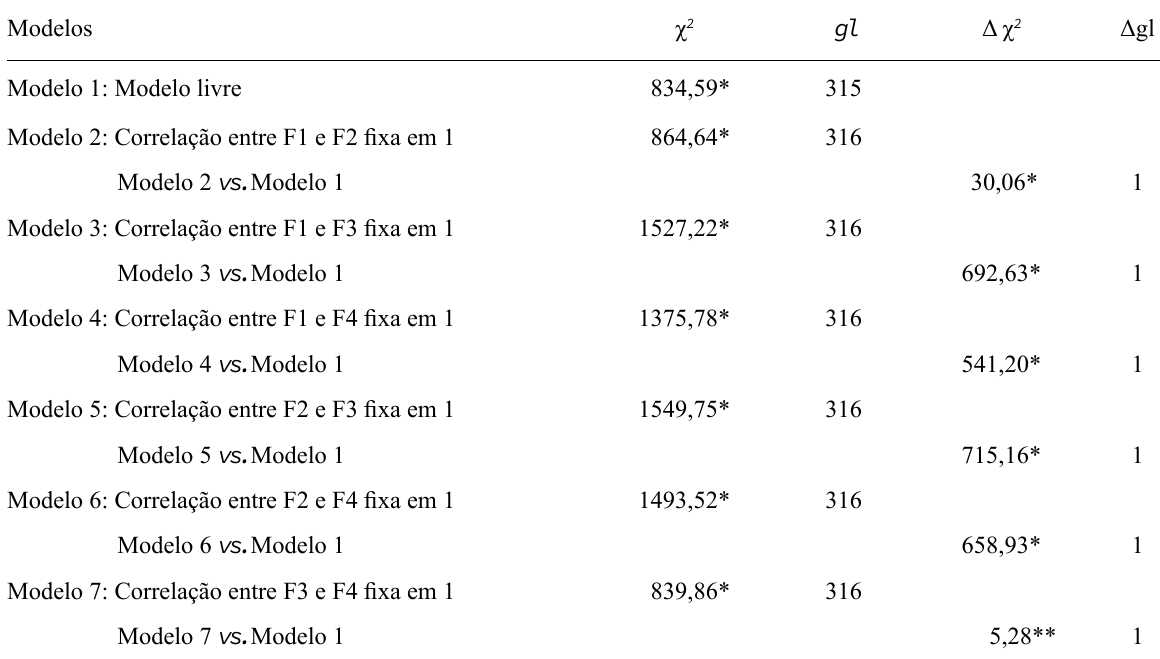
Comparação do Modelo Livre com os Modelos com Correlações entre Fatores Fixas em 1